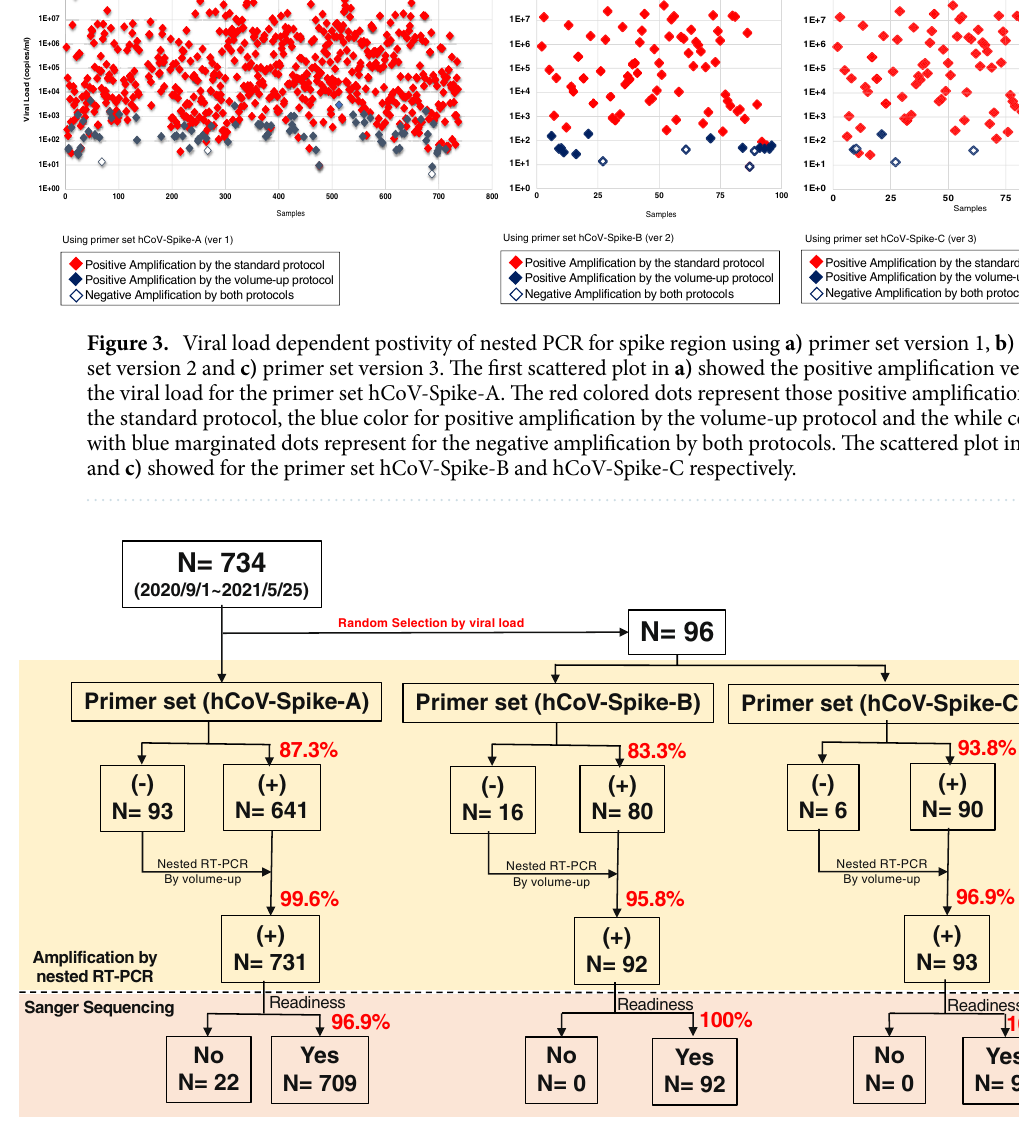
Figure 4. Amplification positive rate and readiness of Sanger sequences using primer set hCoV-Spike-A, hCoV-Spike-B and hCoV-Spike-C. This figure showed the positive rate of amplification by nested RT-PCR using the specific primer set hCoV-Spike-A, hCoV-Spike-B and hCoV-Spike-C respectively and also their readiness of partial genomes after direct